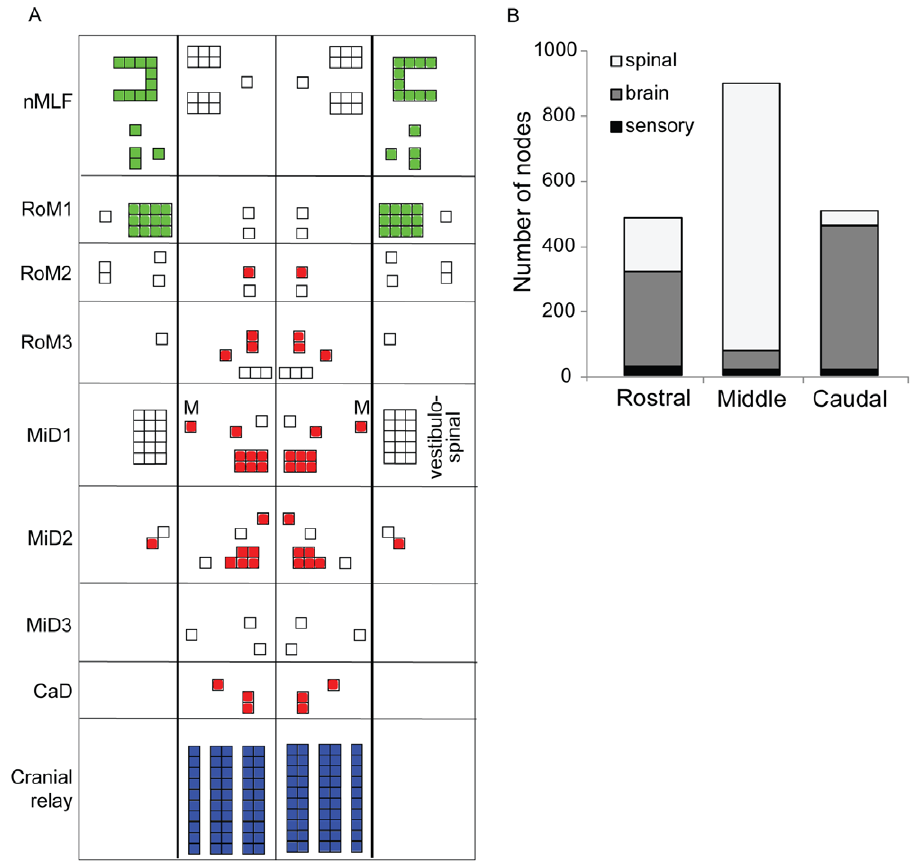
Figure 5. Network modularity. Modules of high interconnectivity were identified using a community detection algorithm. A. A schematic of the zebrafish descending neuron population showing the 3 modules detected in separate colors. Only nodes that placed in the same module across all 100 instantiations of the network were included. Distinct rostral (green), middle (red), and caudal (blue) groups are apparent. Major segments of the hindbrain are labeled for anatomical reference, as are the midbrain nMLF, Mauthner neurons (M), and vestibulospinal neurons. B. The average number of nodes in each brain module (rostral, middle, caudal) across 100 instantiations of the network is shown by the height of the bars. The number of sensory, brain, and spinal nodes within each module is shown by the shading. Nodes in each module largely share afferent and efferent connectivity.